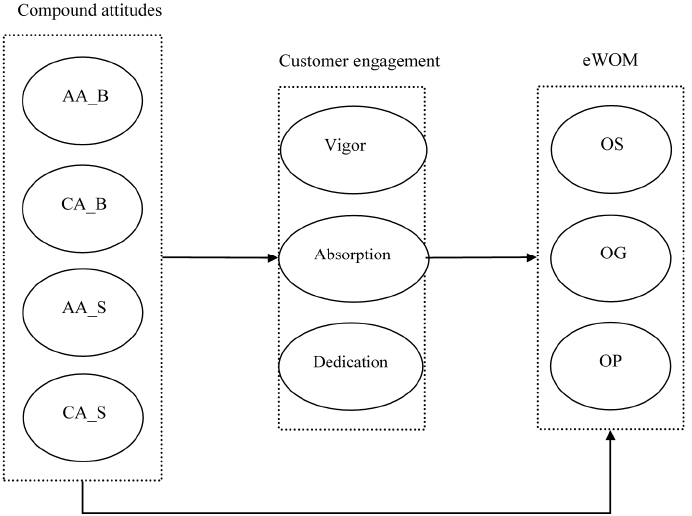
Figure 1. Research model. Note. AA_B = brand (product) related affective attitudes; AA_S = sensor computing platform related affective attitudes; CA_B = brand (product) related cognitive attitudes; CA_S = sensor computing platform related cognitive attitudes; OS = opinion seeking; OG = opinion giving; OP = opinion passing.